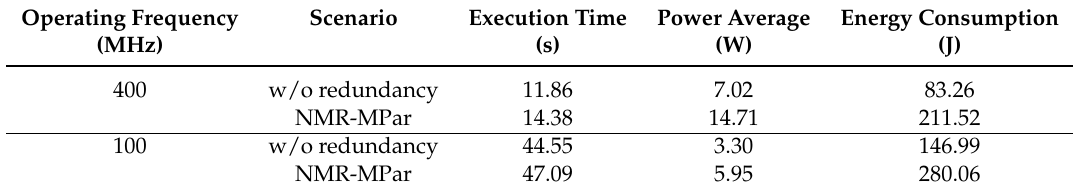
Table 9. Power and energy consumption for the studied scenarios of